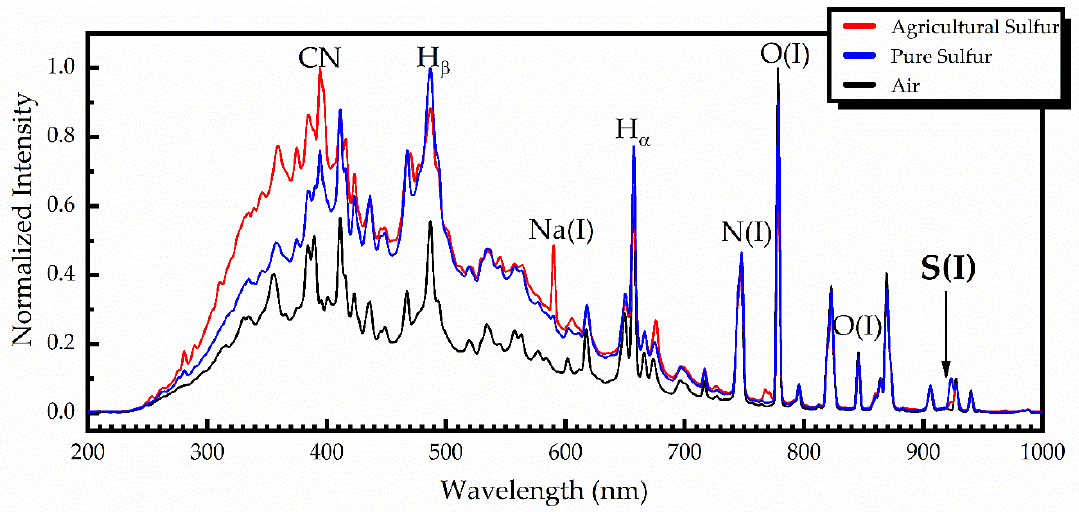
Figure 3. LIBS spectra of pure sulfur (blue), agricultural sulfur (red) and ambient air (black). As can be seen from this figure, the LIBS spectra of pure and agricultural sulfur samples were very similar, exhibiting only minor differences, arising from the impurities contained in the agricultural sulfur samples. As an example, some of the observed differences are zoomed into and are shown in Figure 4. As shown, the sodium spectral lines Na(I) at 589.0 and 589.6 nm, and the potassium spectral lines K(I) at 766.5 and 769.9 nm are clearly observed in the agricultural sulfur LIBS spectra, while they are absent in the pure sulfur spectrum [21,22].